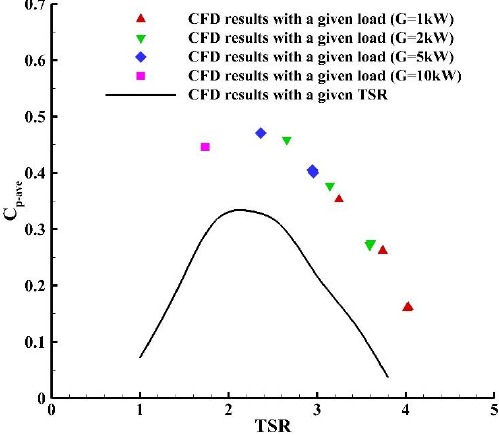
Figure 12. Comparison of C p-ave under passive and forced rotation conditions.